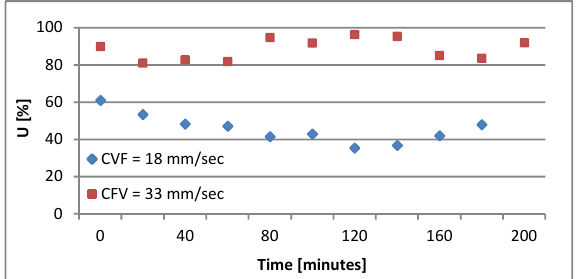
Fig. 14. Uniformity of fouling layer distribution a long hollow fiber membrane vs time at various CFV values (50 cm fiber length, 60 LMH permeate